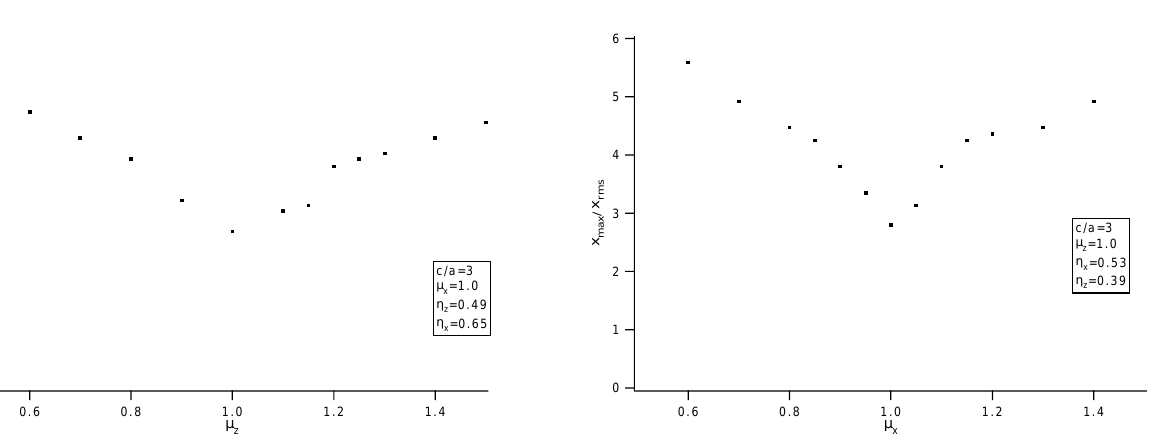
FIG. 16. Extent of the transverse halo for the 6D uniform distribution with zero longitudinal mismatch m (cid:122) (cid:173) (cid:49)(cid:46)(cid:48) ( (cid:99) (cid:121) (cid:97) (cid:173) (cid:51)(cid:44) h (cid:120) (cid:173) (cid:48)(cid:46)(cid:53)(cid:51)(cid:44) h (cid:122) (cid:173) (cid:48)(cid:46)(cid:51)(cid:57)